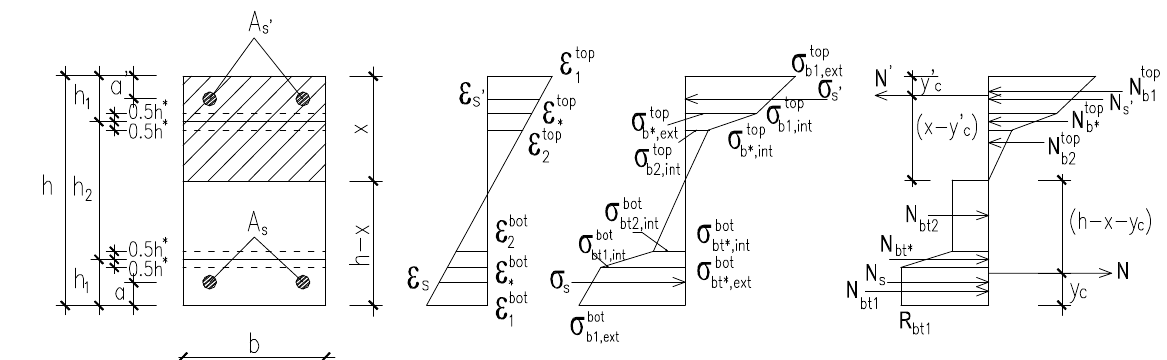
Figure 5. The calculation scheme B for the distribution of deformations, stresses, and forces in the three-layer without considering the contact interlayers [1].